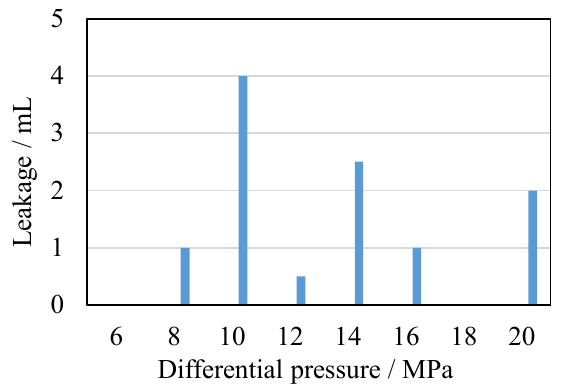
µ m fracture plugging